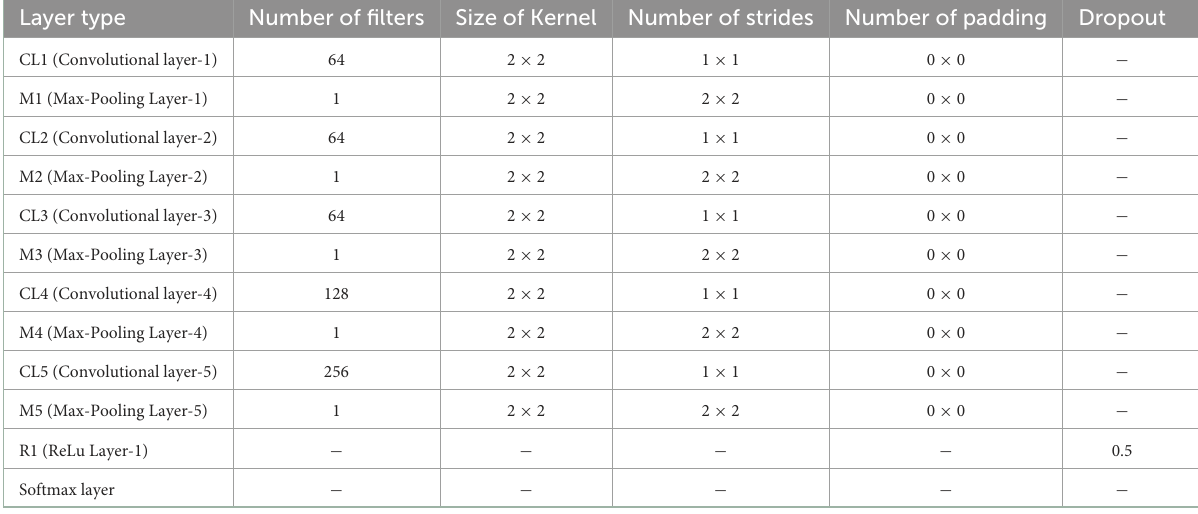
TABLE 3 CNN parameters for the third, the fourth, the fifth, and the sixth feature maps. Layer